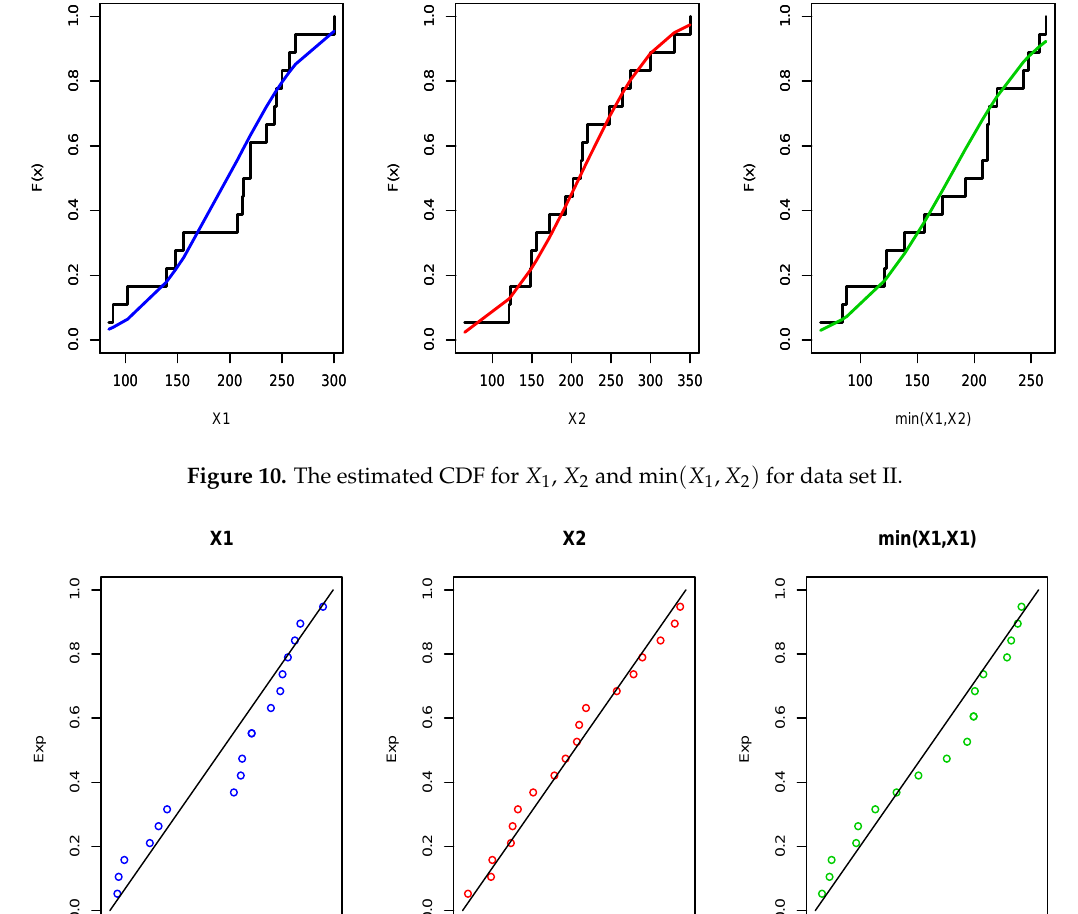
Figure 11. The PP plots for X 1 , X 2 and min ( X 1 , X 2 ) for data set II.